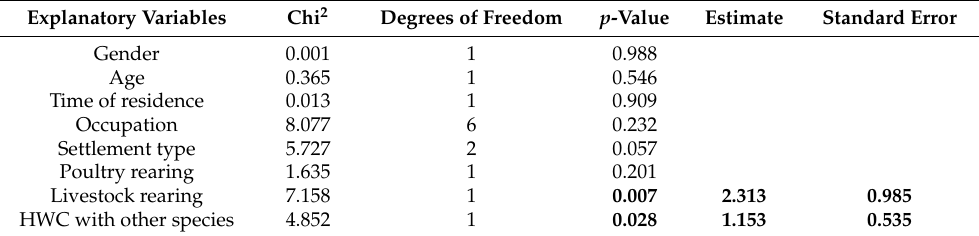
Table 5. Deviance analysis results showing the effect of each factor used in the binomial general- ized linear model for the response variable conflicts with Andean condors and their significance, performed with the Anova function of “car” package. Explanatory variables with p -values <0.05 are in bold. Estimated coefficients and standard errors are shown for the significant categories (yes) of the significant social factors.